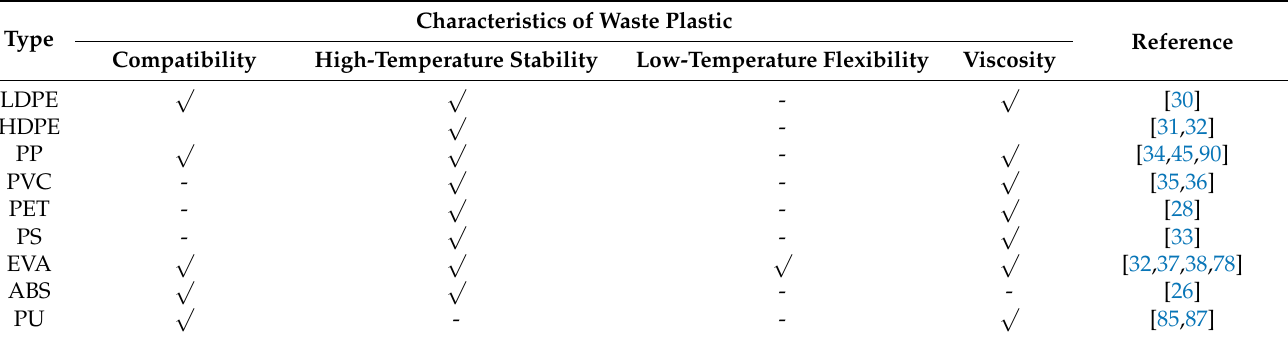
Table 4. Characteristics of common waste